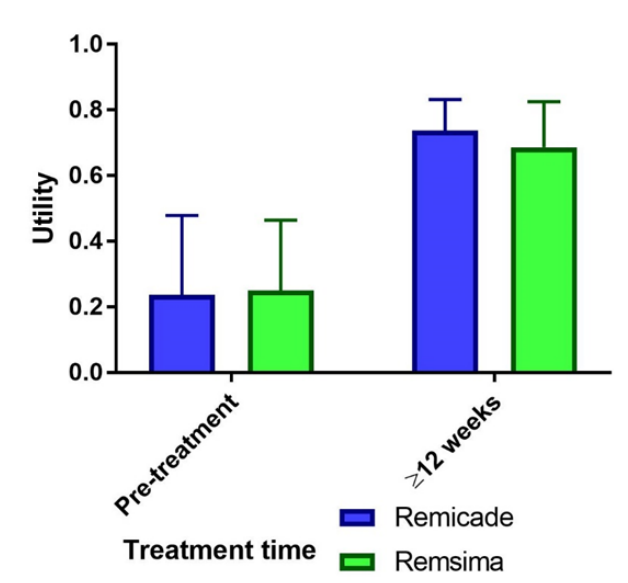
Table 3: Cost and benefit of both reference and biosimilar